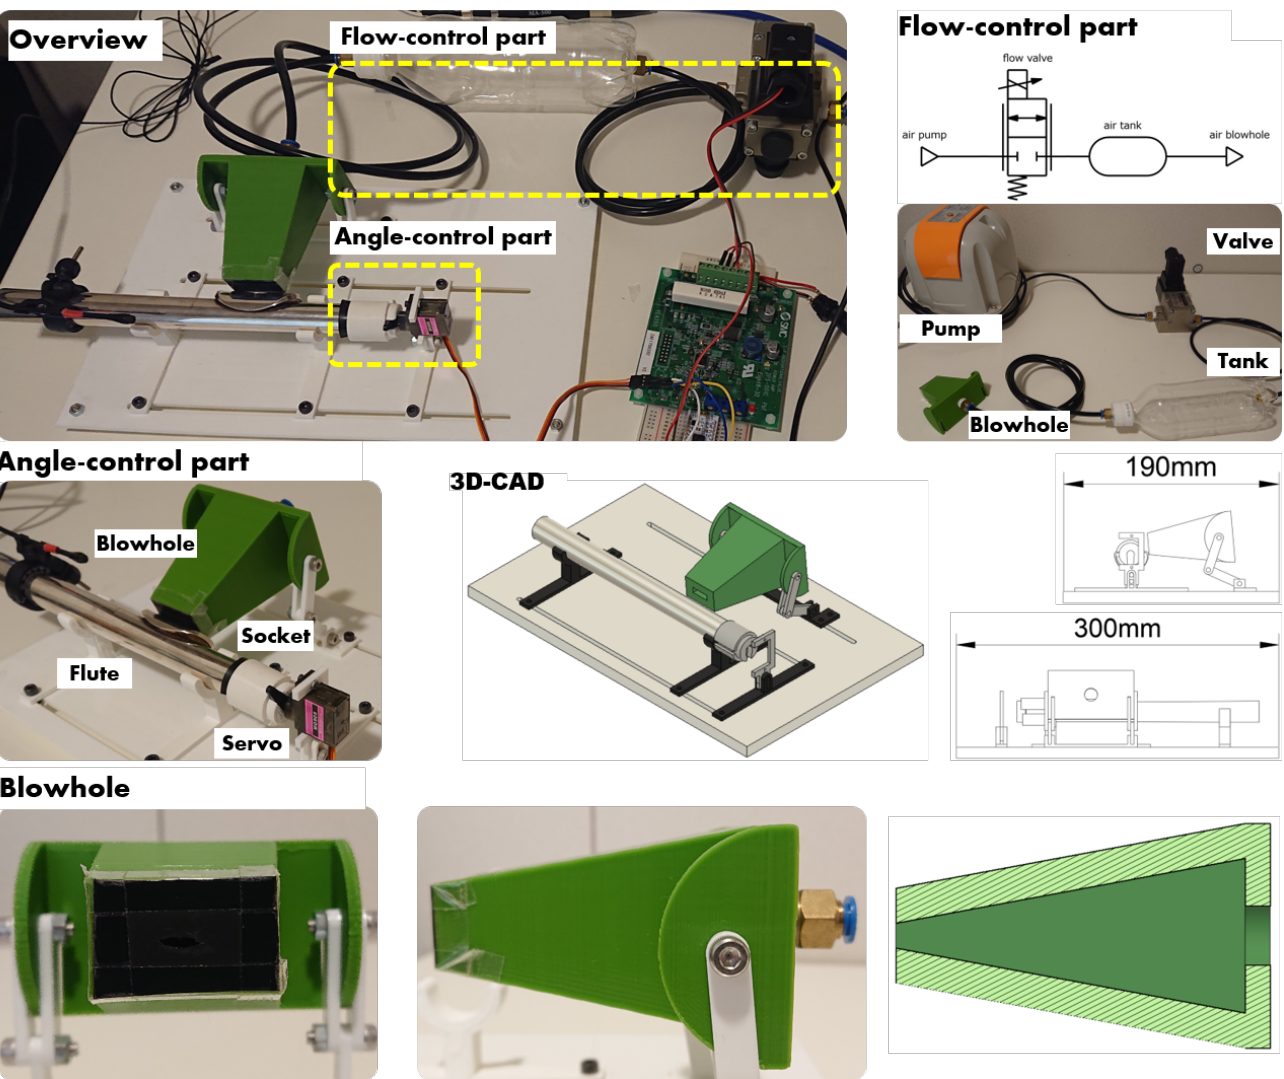
Figure 3. Overall diagram of the flute-playing robot. A servo motor is connected to the flute body, and the angle at which the breath is blown into the instrument can be adjusted by rotating the motor. In addition, the flow rate of the breath into the instrument can be adjusted by adjusting the opening of the flow valve in the air